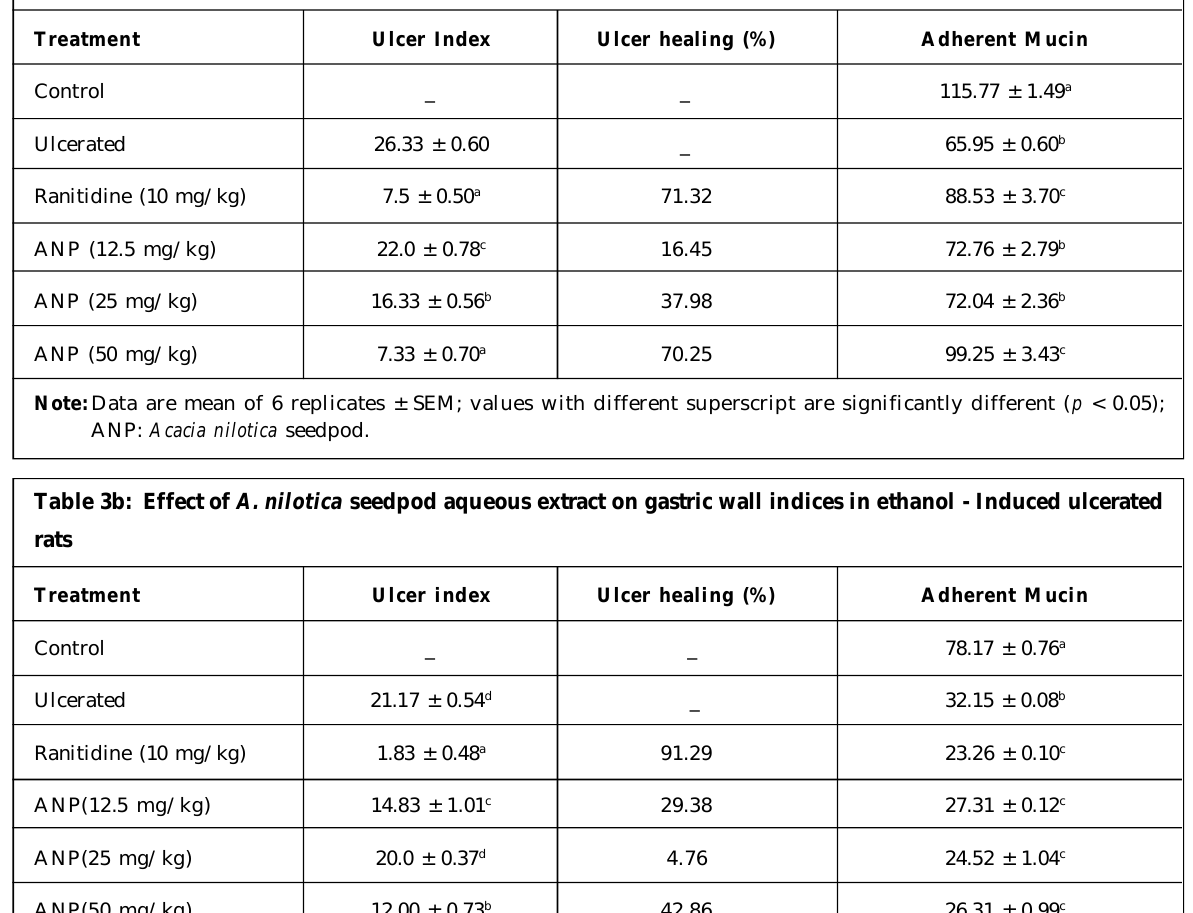
Table 3a: Effect of A. nilotica seedpod aqueous extract on gastric wall indices in indomethacin - Induced ulcerated rats Treatment